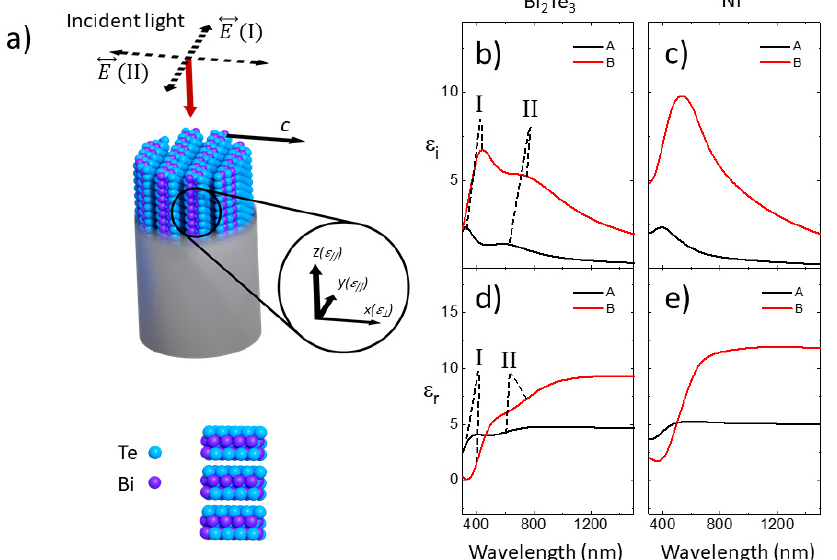
Figure 5. ( a ) Scheme of the relative orientation of Bi 2 Te 3 dielectric constants deposited inside the alumina templates, with the c -axis perpendicular to the nanowire axis. The bismuth and tellurium atoms are represented schematically by violet and blue spheres, respectively. A scheme of the different polarization of the incident light, which excite plasmon resonances, E(I) (polarization perpendicular to the c -axis) and E(II) (polarization parallel to the c -axis), is shown. These components are responsible for the plasmons labeled I and II. ( b – e ) Calculated spectra of the imaginary part ( b , c ) and real part ( d , e ) of the in-plane effective dielectric constant of 1D nanowire arrays with 100 nm inter-wire distance (black line, labeled A), and 1D nanowire arrays with 65 nm inter-wire distance (red line, labeled B) made of Bi 2 Te 3 ( b , d ) and Ni ( c , e ).